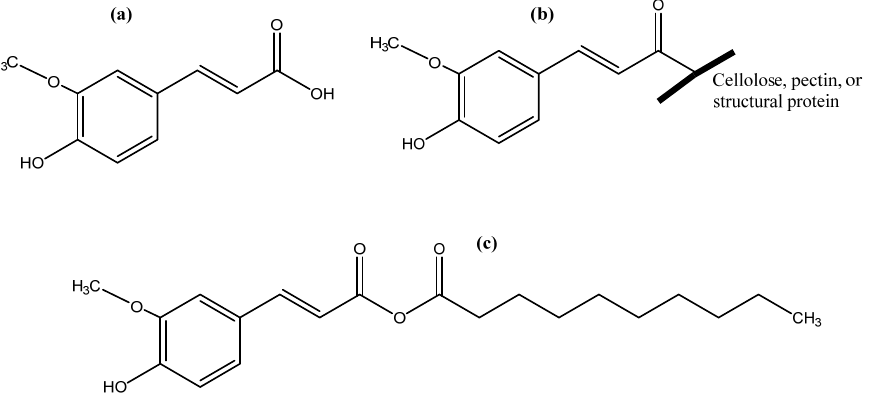
Figure 1. Free ( a ), bound ( b ), and ester form ( c ) of ferulic acid.